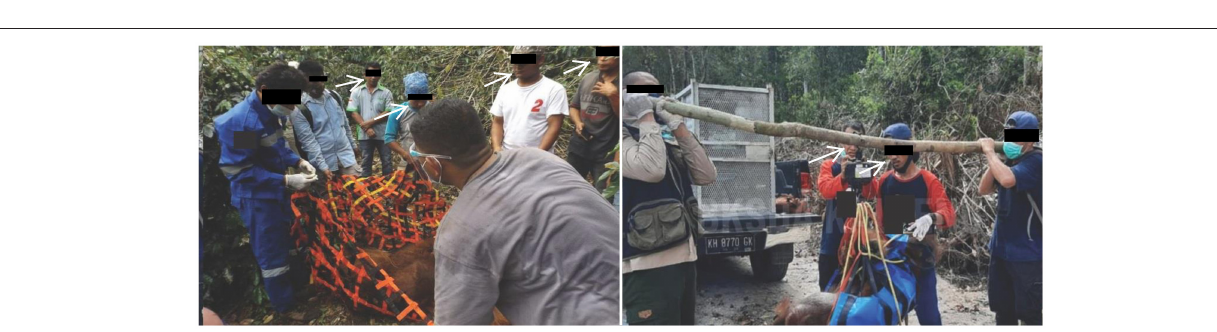
FIGURE 2 | PPE use and human proximity in wild-to-wild orangutan translocations during COVID-19 pandemic. Pictures showing examples of mixed use of PPE and human proximity to orangutans during captures and releases of wild orangutans between March 15, 2020 and March 14, 2021. The orangutans are in the blue sling and the orange and black net, respectively. Identifiable human features and organizational logos are obscured to protect anonymity. Image credits from left to right: BBKSDA Sumatera Utara via KSDAE Top News blog http://ksdae.menlhk.go.id/assets/uploads/ou_sipirok2.JPG ( 70); BKSDA Kalimantan Tengah via Facebook https://www.facebook.com/BKSDAKalimantanTengah/posts/1365289040500502 (